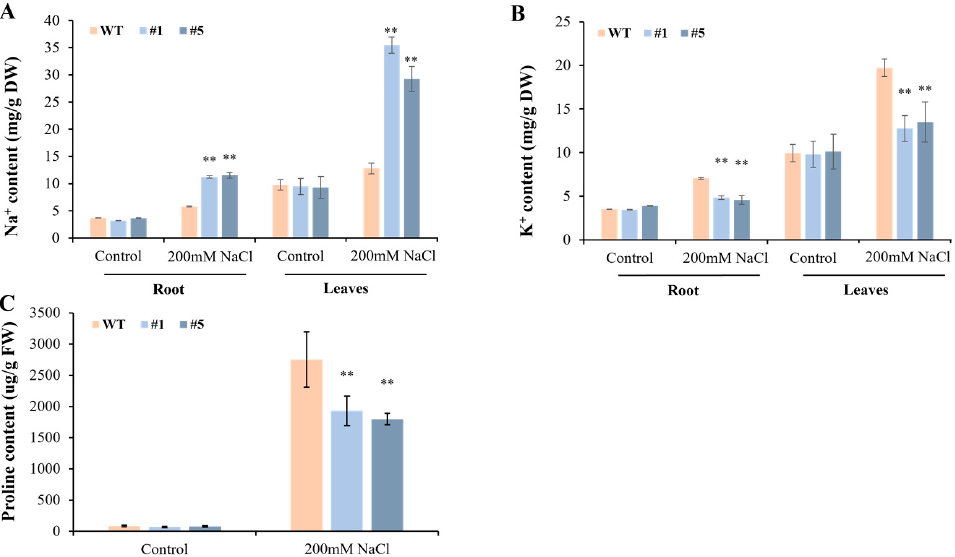
Figure 10. Na + , K + , and proline contents in Col-0 and CmHSP90.5 -overexpressed plants under 200 mM NaCl. ( A , B ) Na + and K + contents in roots and leaves of the plant. ( C ) Proline content in CmHSP90.5 transgenic Arabidopsis and Col-0 plants. Error bars represent ± SE. ** Statistically significant differences were compared with Col-0 plants under different conditions. Value of p < 0.01 was considered to be statistically significant.